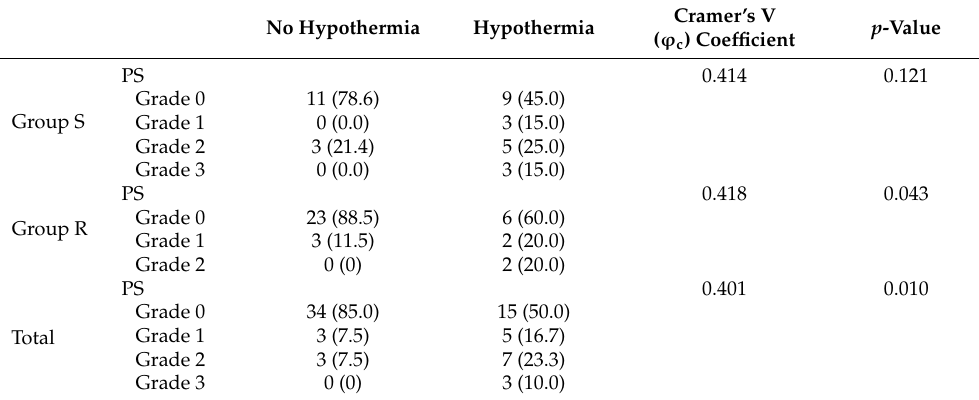
Table 3. The association between the severity of PS and the incidence of hypothermia in the PACU. PS Total